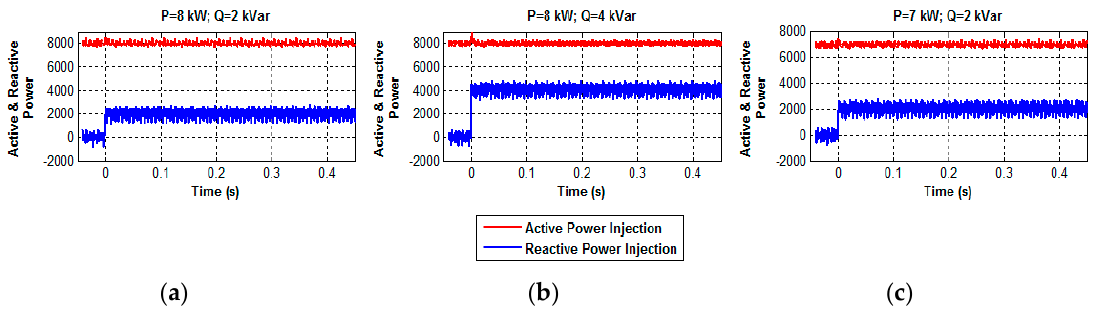
Figure 23. Injection of reactive power: ( a ) Step change from 0 to 2 kVar when active power injection is 8 kW; ( b ) Step change from 0 to 4 kVar when active power injection maintain at 8 kW; ( c ) Step change from 0 to 2 kVar when active power injection is 7 kW.